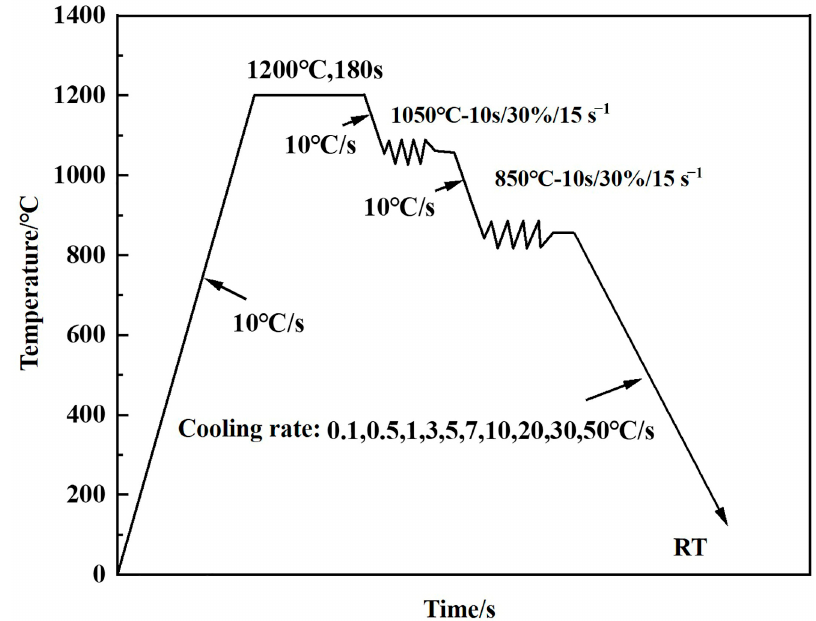
Figure 1. Dynamic CCT test measurement curve.